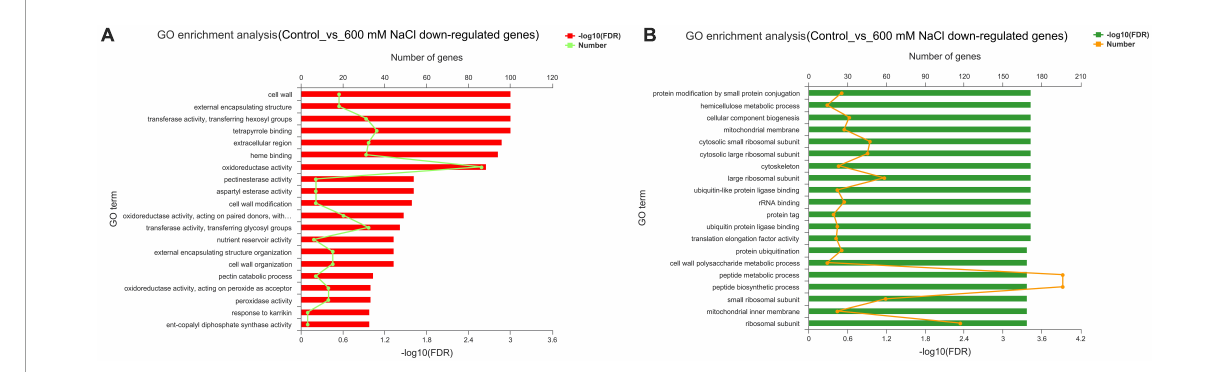
FIGURE6 GO enrichment analysis of DEGs in the leaves of S. portulacastrum under high salinity. (A) Upregulated genes, (B) downregulated genes.